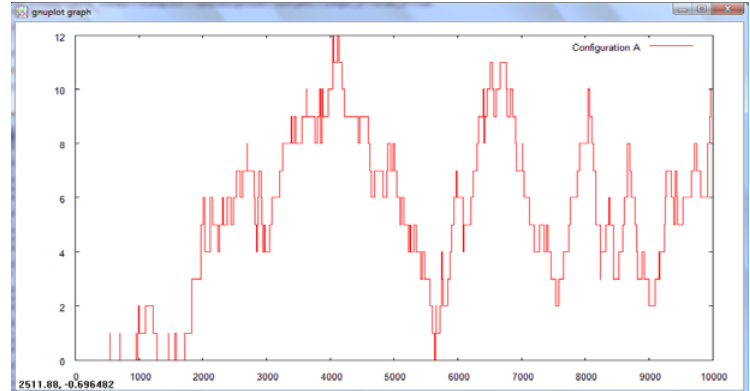
Fig. 7. Queue length in design